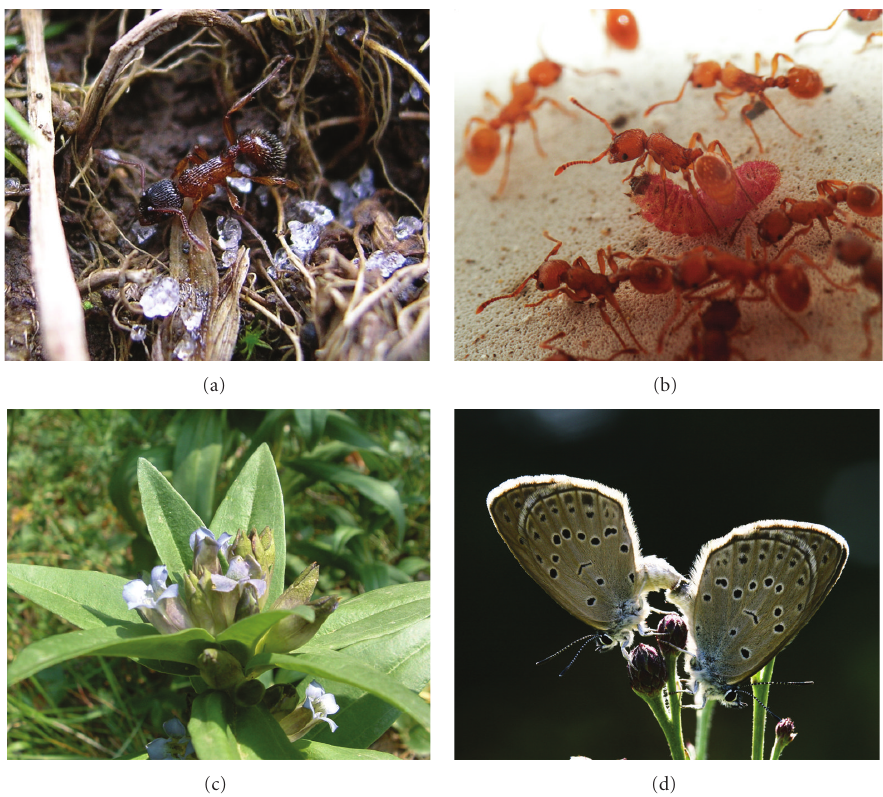
Figure 1: (a) Forager worker of Myrmica ant. (b) Trophallaxis between attendance worker and Maculinea larva. (c) Maculinea rebeli foodplant: Gentiana cruciata . (d) Mating of Maculinea